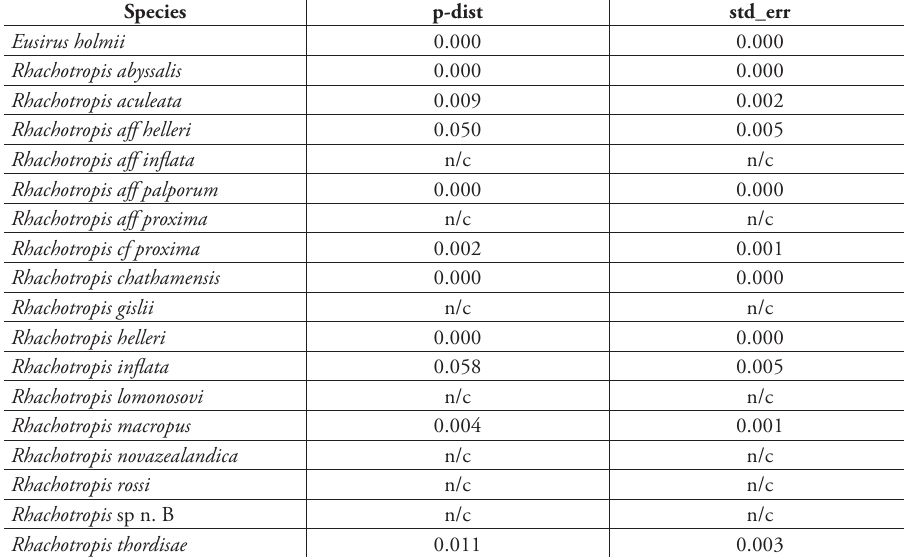
Table 2. Estimates of Average Evolutionary Divergence over Sequence Pairs within morphologically defined groups. The number of base differences per site from averaging over all sequence pairs within each group are shown. Standard error estimate(s) are shown in the last column. The analysis involved 82 nu- cleotide sequences. Codon positions included were 1st+2nd+3rd. All ambiguous positions were removed for each sequence pair. There were a total of 648 positions in the final dataset. Evolutionary analyses were conducted in MEGA7. The presence of n/c in the results denotes cases in which it was not possible to estimate evolutionary